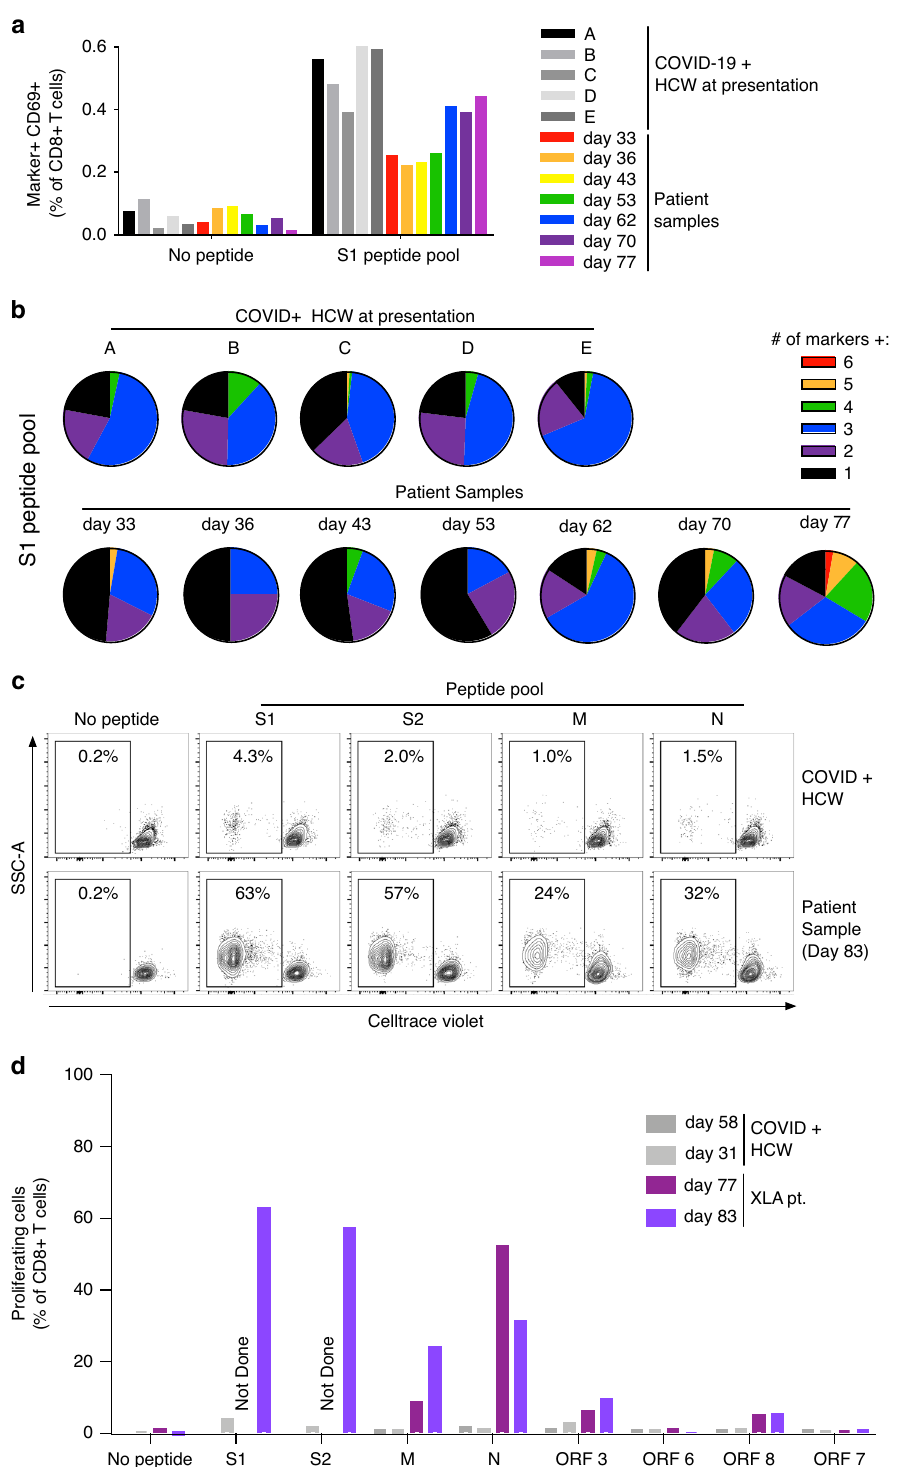
Fig. 3 Kinetic assessment of the antigen-speci fi c CD8 + T-cell responses. a % CD8 + T cells expressing activation makers after incubation ± a peptide pool covering the SARS-CoV-2 S1 protein. Patient samples obtained at indicated time points are compared with HCWs with PCR-con fi rmed COVID-19 at presentation ( n = 5 biologically independent subjects). b Number of activation markers expressed by S1-responsive CD8 + T cells from a . Representative fl ow cytometry dot plots c and % proliferating CD8 + T cells d after stimulation ± peptide pools covering the indicated SARS-CoV-2 proteins. Patient samples are compared with HCWs ( n = 2 biologically independent subjects) with PCR-con fi rmed COVID-19 at indicated time points. Data from one independent